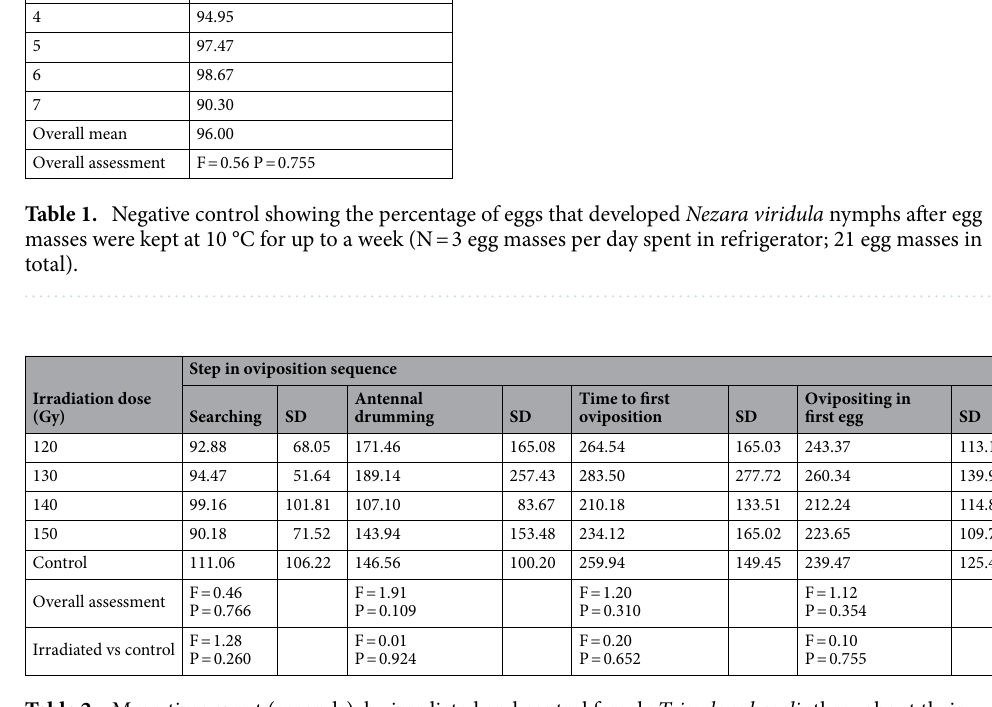
Table 2. Mean time spent (seconds), by irradiated and control female Trissolcus basalis throughout their lifespans, undertaking each step in the oviposition sequence.